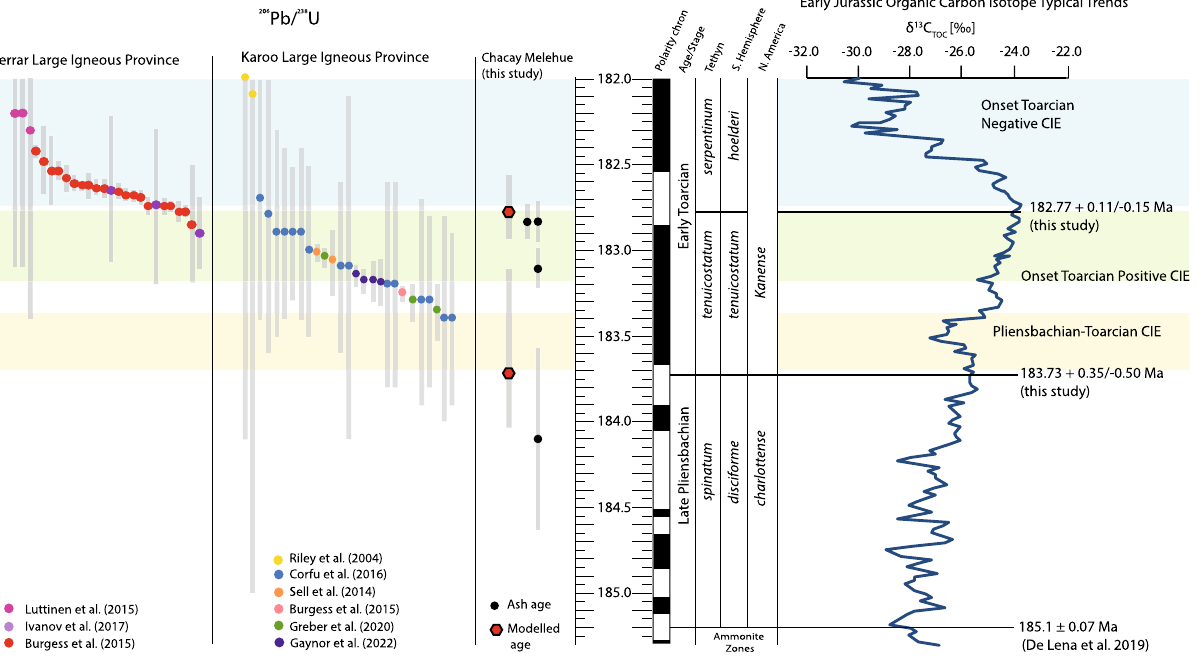
Figure 5. Distribution of 206 Pb/ 238 U absolute ages from the Karoo and Ferrar Large Igneous Provinces, and dates from this study on a numerical timescale, relative to the carbon-isotope data (2-pt moving average) from the Mochras Borehole (Cardigan Bay Basin, UK 45,60 ), spanning the Pliensbachian–Toarcian transition. The numerical timescale is obtained using age tie-points for the ammonite zone boundaries based on geochronological constraints from this study, and linear interpolation in between. Major carbon-cycle perturbations are also indicated. Magnetic polarity scale adapted from Hesselbo et al. 1 (References for Karoo and Ferrar dates are available in the supplementary data